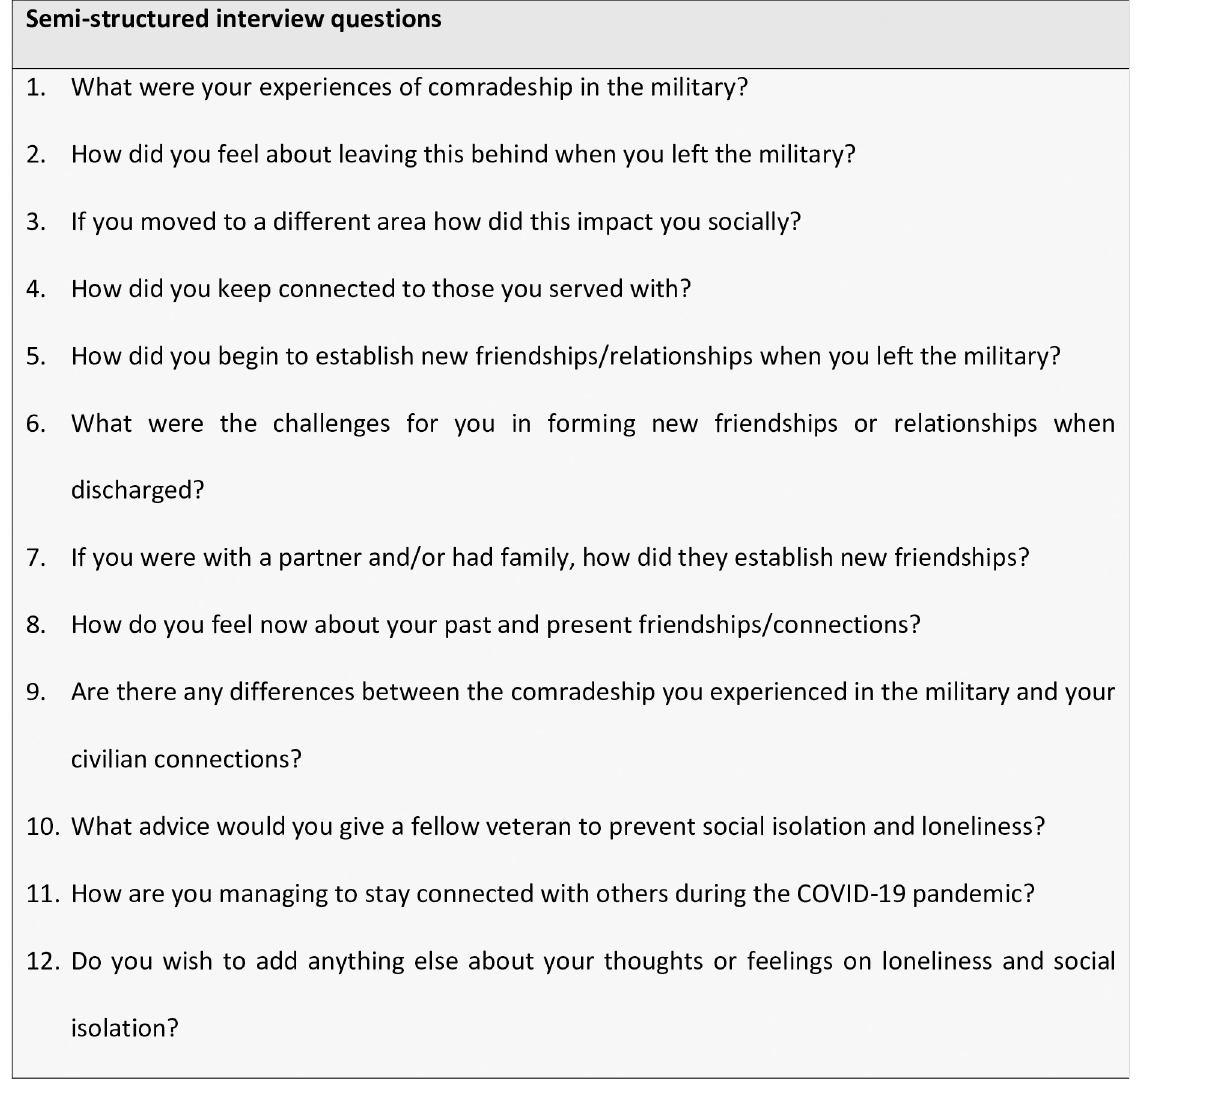
Fig 1. Semi-structured interview